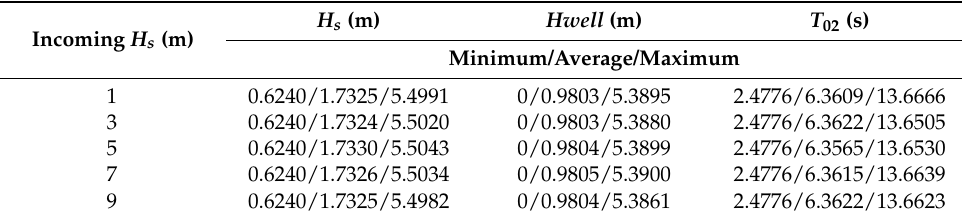
Table 2. The statistics of wave information with the varying incoming H s . Hwell : wave spectrum.